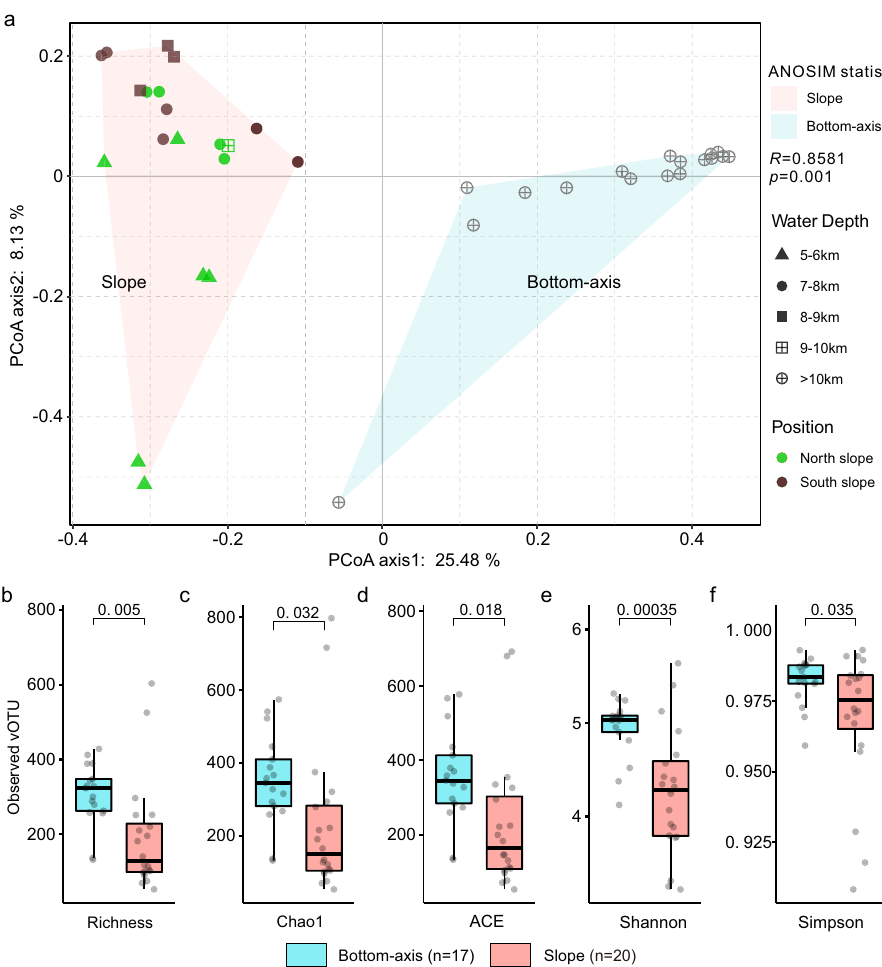
Fig. 4 Alpha- and beta-diversity of CD viral communities. a Bray – Curtis dissimilarity principal coordinate analyses (PCoA) of the viral communities. The pink and blue areas covered slope and bottom-axis samples, respectively. b – f Estimated number of vOTUs, Chao1, ACE, Shannon, and inverse Simpson indices of the viral community diversity from the CD slope (red, n = 20) and bottom-axis (blue, n = 17) sediments. p value was estimated using the two- sided Student ’ s T Test. For boxplots, center line indicates median, bounds of box indicate 25th and 75th percentiles, and whiskers indicate minimum and